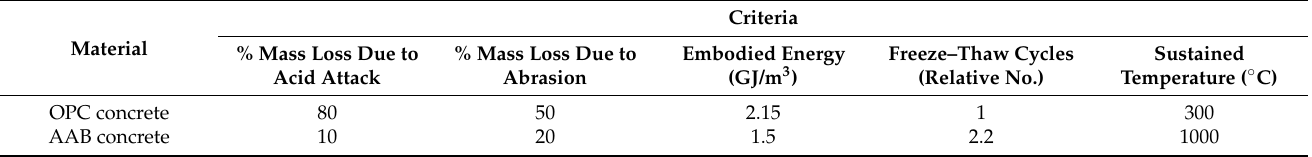
Table 3. Quantitative data of material selection attributes [41].